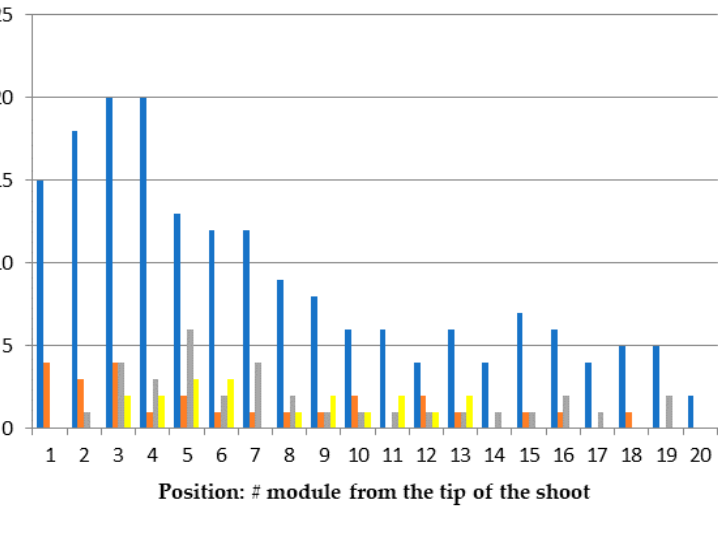
Figure 8. Dependence of the frequency of occurrence of the most common morphovariations on the position on the D. pumila shoot in a sample of 10,008 modules. The Y-axis shows the number of morphovariations in this position. Different colors are representing four morphovariation (according to nomenclature of Section 3.2).